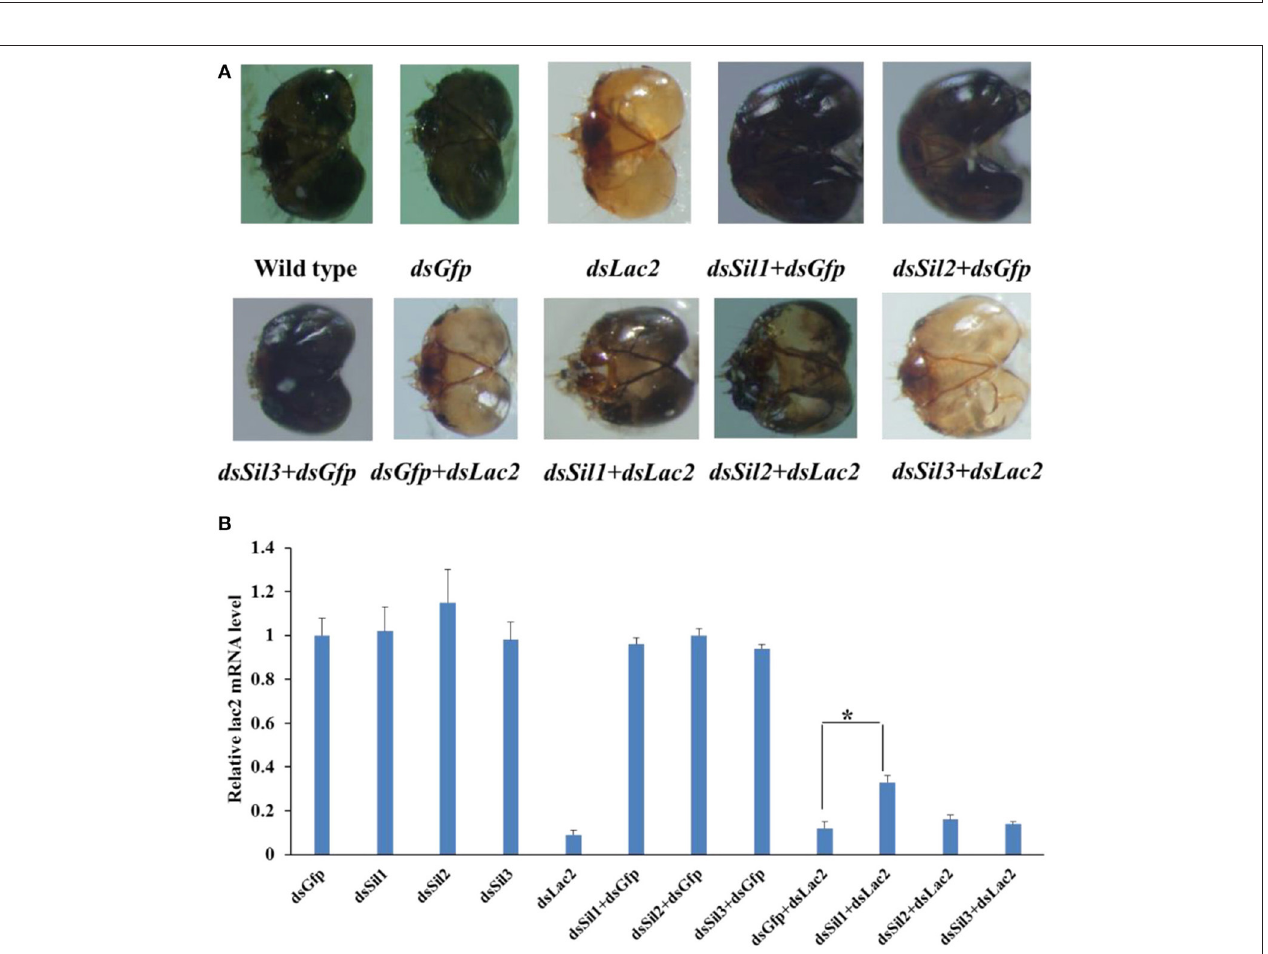
FIGURE 13 | Sil RNAi efficiently suppressed the Lac2 RNAi. (A) Heads of a wild-type larvae as well as larvae fed Gfp dsRNA, Lac2 dsRNA, Sil1 dsRNA + Gfp dsRNA, Sil2 dsRNA + Gfp dsRNA , Sil3 dsRNA + Gfp dsRNA , Gfp dsRNA + Lac2 dsRNA, Sil1 dsRNA + Lac2 dsRNA, Sil2 dsRNA + Lac2 dsRNA, or Sil3 dsRNA + Lac2 dsRNA. Both Sil1 and Sil2 RNAi suppressed the Lac2 RNAi phenotype. (B) Relative Lac2 expression level based on a qRT-PCR. The Lac2 expression level was higher in larvae fed Sil1 dsRNA + Lac2 dsRNA than in control larvae (i.e., fed Gfp dsRNA + Lac2 dsRNA). Data were analyzed using Student’s t -test (* p < 0.05).